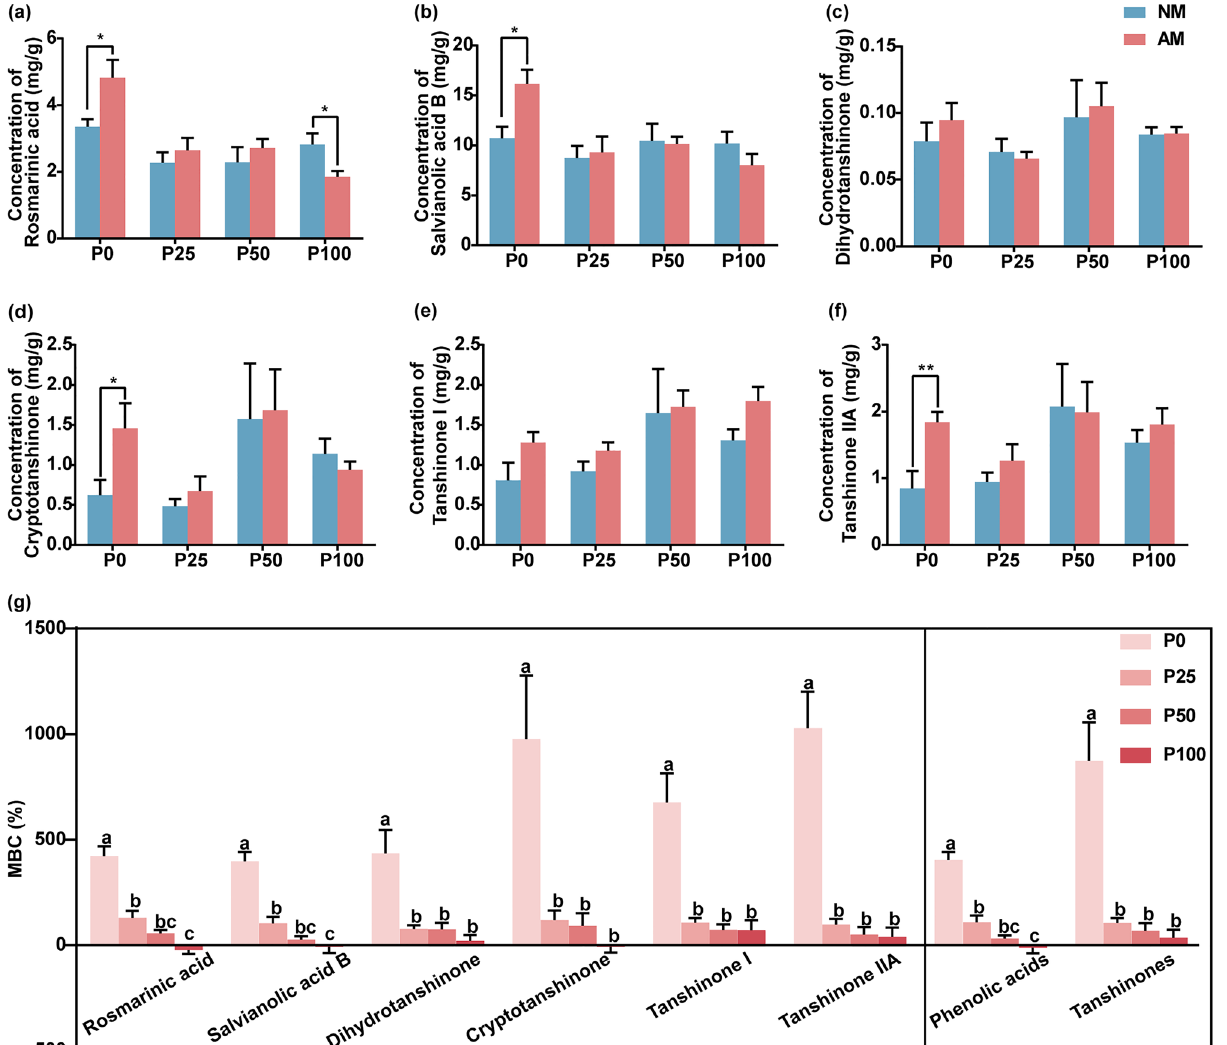
Figure 3. Mycorrhizal response of bioactive compounds (MBC) under different levels of P (0, 25, 50, and 100 mg P fertilizer added per kilogram of soil; P0, P25, P50, P100) fertilizer. ( a–f ) The concentrations of bioactive compounds, rosmarinic acid ( a ), salvianolic acid ( b ), dihydrotanshinone ( c ), cryptotanshinone ( d ), tanshinone I ( e ), and tanshinone IIA ( f ) in the roots of S. miltiorrhiza under different treatments. The means ± standard errors are shown (n = 6). Asterisks indicate significant differences between arbuscular mycorrhizal plants and non-mycorrhizal plants according to the t-test (*0.01 ≤ P ≤ 0.05, **0.001 ≤ P ≤ 0.01, *** P ≤ 0.001). ( g ) Mycorrhizal response of bioactive compounds (MBC) under different levels of P fertilizer. The means ± standard errors are shown (n = 6). Different lowercase letters indicate significant differences between different treatments according to one-way ANOVA followed by Tukey’s test for multiple comparisons ( P < Differences in mycorrhizal efficiency were observed at different N levels. Under the N25 treatment, the MGR of both the shoots and roots was the highest, whereas that of the N0 treatment was the lowest (Fig. 2d). Applica- tion of a low level of nitrogen fertilizer (N25) is thus conducive to the development of mycorrhizal benefits to plant growth. Promotion of bioactive compounds accumulation by AMF was severly inhibited by P ferti- lizer. The bioactive compounds in the roots of S. miltiorrhiza include phenolic acids (rosmarinic acid, salvia- nolic acid B) and tanshinones (dihydrotanshinone, cryptotanshinone, tanshinone I, tanshinone IIA). P fertilizer affected the MBC in the roots of S. miltiorrhiza . Under P0 treatment, compared with non-mycorrhizal plants, AMF colonization significantly increased the concentrations of rosmarinic acid by 43.9% (Fig. 3a), salvianolic acid B by 50.9% (Fig. 3b), cryptotanshinone by 134.0% (Fig. 3d), tanshinone IIA by 117.4% (Fig. 3f). Under the P100 treatment, AMF colonization significantly decreased the concentrations of rosmarinic acid by 34.3%. Under the P25, P50, and P100 treatments, there was no significant difference in the concentrations of salvianolic acid B (Fig. 3b), dihydrotanshinone (Fig. 3c), cryptotanshinone (Fig. 3d), tanshinone I (Fig. 3e), and tanshinone IIA (Fig. 3f) between mycorrhizal S. miltiorrhiza and non-mycorrhizal S. miltiorrhiza .